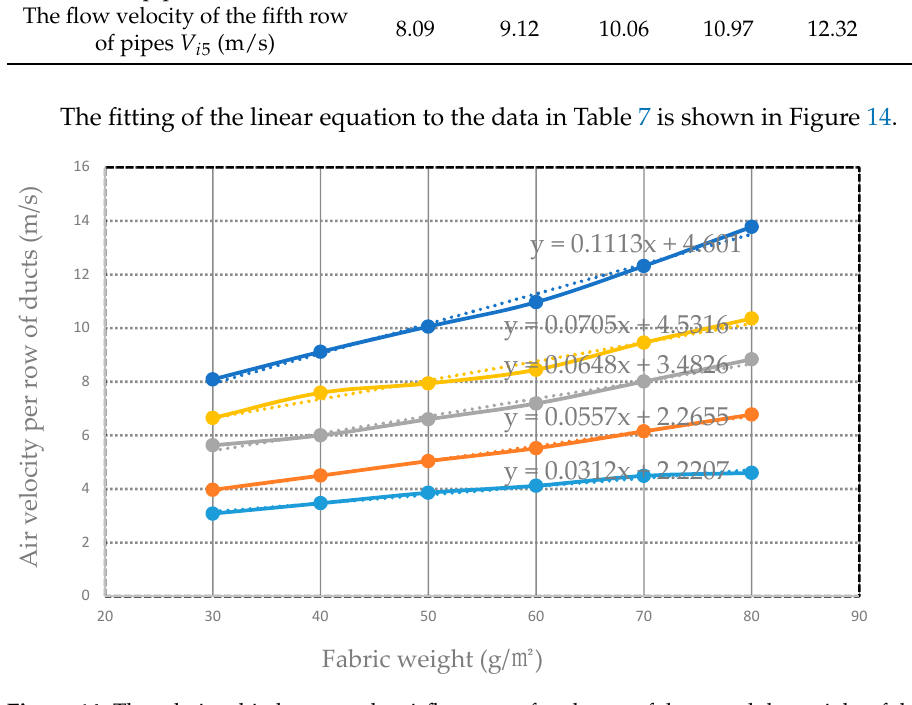
Figure 14. The relationship between the airflow rate of each row of ducts and the weight of the fabric.